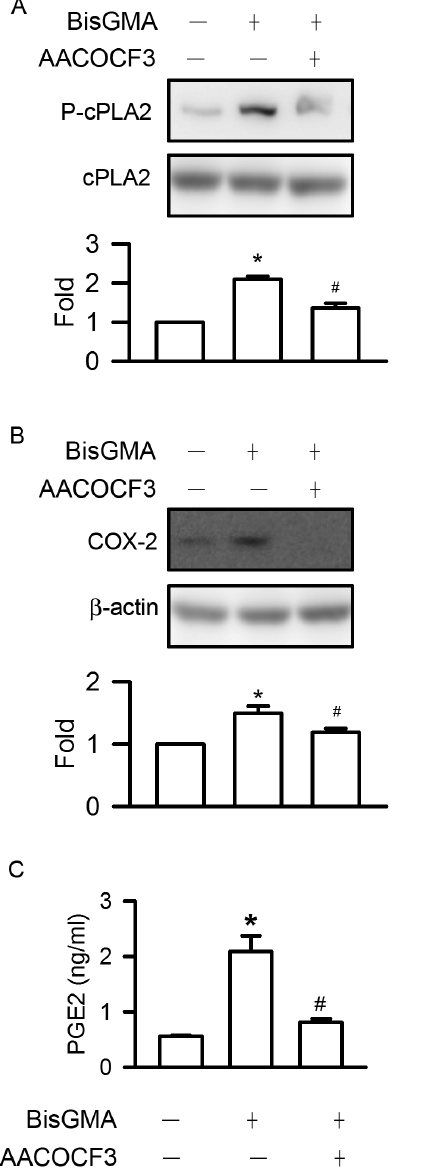
Figure 4. Effects of AACOCF3 on the cPLA2 phosphorylation, COX-2 expression, and PGE2 generation. After treatment with 30 m M AACOCF3 for 30 min, RAW264.7 macrophages were stimulated with 3 m M BisGMA for 2 h. Cells were harvested and protein extracts were subjected to SDS-PAGE. Western blot analysis using antibodies against (A) phosphorylated and total cPLA2; (B) COX-2 and b -actin. The ratio of immunointensity between the phosphorylation and total protein was calculated. Values are expressed as mean 6 SD (n=3). *represents significant difference from control values with p , 0.05. (C) The supernatant was harvested and detected by ELISA assay of PGE2. Values are expressed as mean 6 SD (n=3). *represents significant difference from control values with p , 0.05. doi:10.1371/journal.pone.0082942.g004 BisGMA for 15 min. After treatment, 50 m g of cell lysate protein, was separated by SDS-PAGE, and electrophoretically transferred to polyvinylidene difluoride membrane. The membranes were blocked with 5% (w/v) nonfat dried milk for 1 h at room temperature to reduce nonspecific binding, washed with PBS